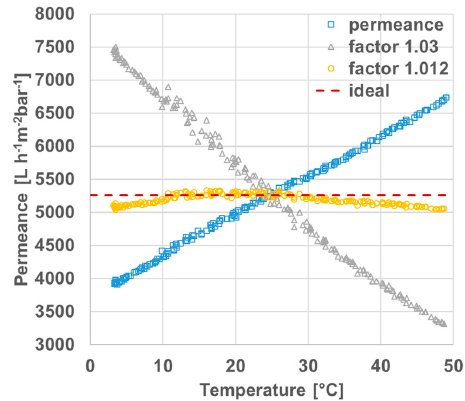
Figure 3. Temperature-dependent permeances of polyethersulfone membranes: original measured permeance (squares), including correction factor of 1.03 as suggested in the literature [37] (triangles), including correction factor of 1.012 determined in this work (circles) and ideal graph (dashes).